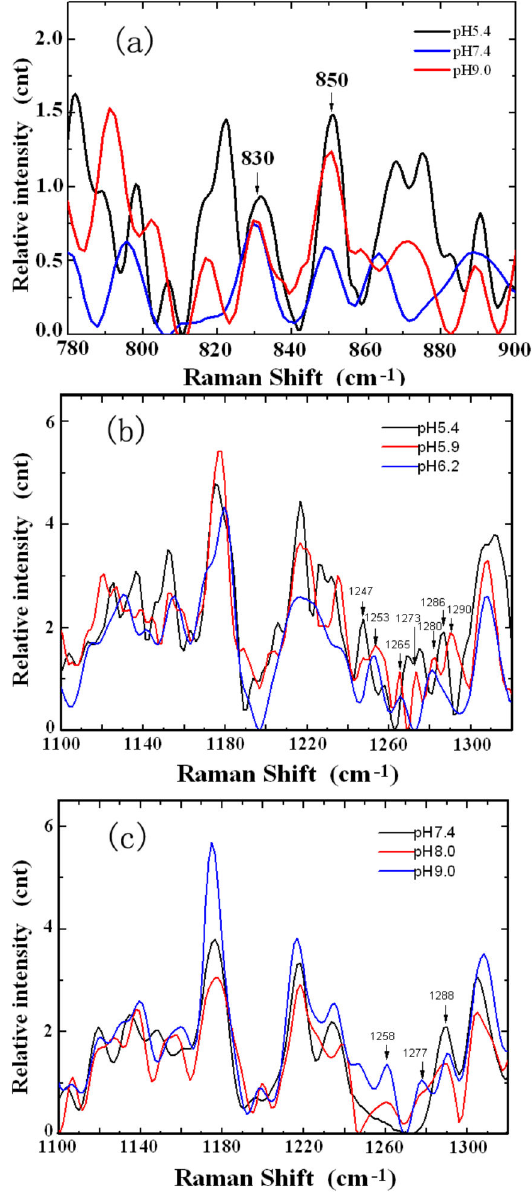
The Raman spectra of hemoglobin. (a) the averaged and standard deviation Raman spectrum calculated from spectra recorded of 25 hemoglobin solutions of pH 7.4; (b) the Raman shifts of human Hb from 600-1800cm -1 in various pH conditions and (c) the variation of the peak intensity at 1358 cm -1 vs. pH.